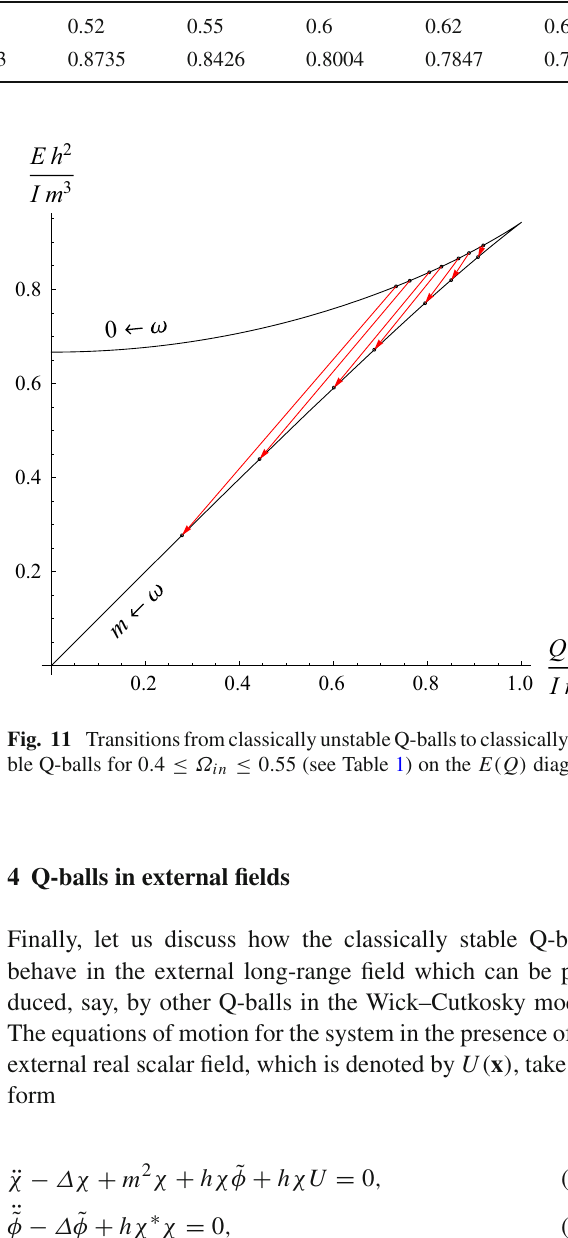
Fig. 10 Evolution of the Q-ball with Ω in = 0 .